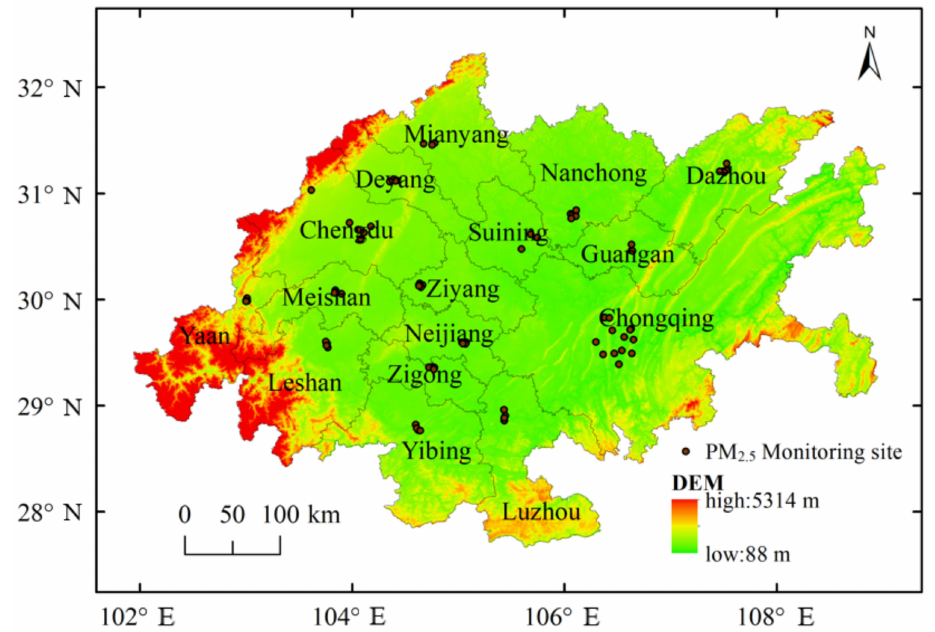
Figure 1. Schematic diagram of study area and ground monitoring